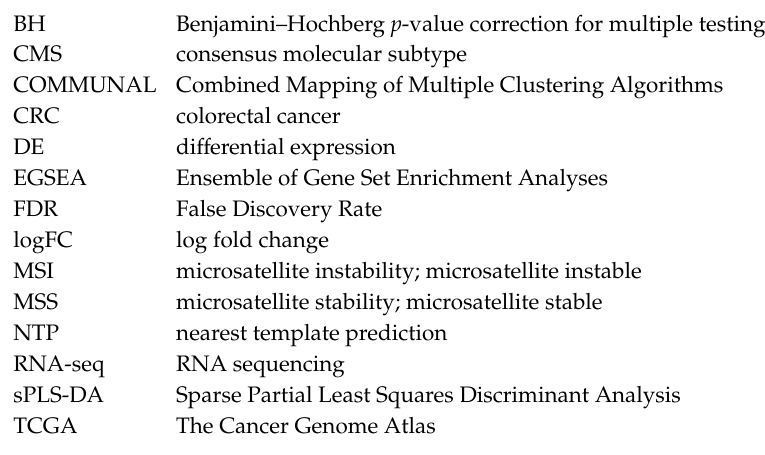
Table S1: Results of gene set enrichment analysis in a CRC RNA-seq dataset by comparing 2055 gene sets in tumor vs. adjacent normal tissue; Table S2: List of 46 selected autophagy genes; Table S3: Results of di ff erential expression analysis (autophagy clusters vs. normal adjacent tissue; Table S4: Statistical procedures utilized in this